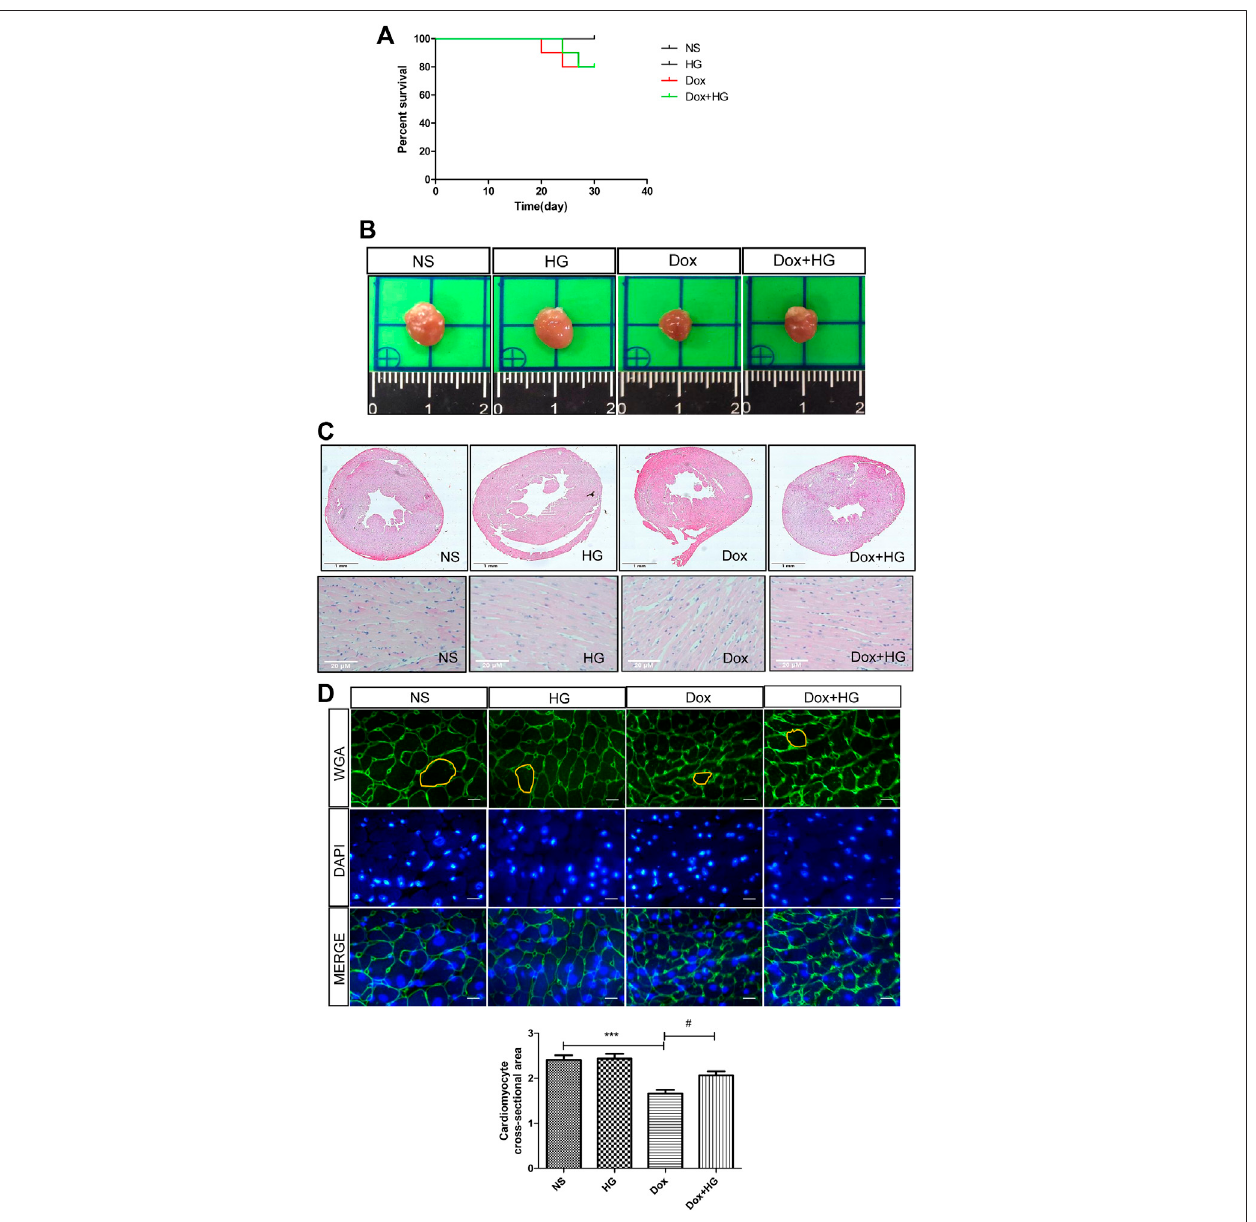
FIGURE 2 | HG attenuated DOX-induced cardiac injury in vivo . (A) Survival curve of mice. (B) Representative heart images of each group. Mice were injected with normal saline (NS) or DOX (5 mg/kg/3 days) and systemically administrated with HG (10 mg/kg/day) during DOX injection for 4 weeks. (C) Schematic diagram of HE stainingoftheheartcross-sectional areaforeachgroup. (D) SchematicdiagramofrepresentativehearttissueWGAstainingforeachgroupofmice. (E) Quanti fi cationof the cross-sectional area of single cardiac muscle cells after WGA staining. All values are presented as mean ± SEM; statistical analysis was performed using Prism 8.0 one-way ANOVA. * p < 0.05 DOX vs NS; # p < 0.05 DOX + HG vs DOX. Animal numbers: NS, n = 8; HG, n = 7; DOX, n = 10; Dox + HG, n =